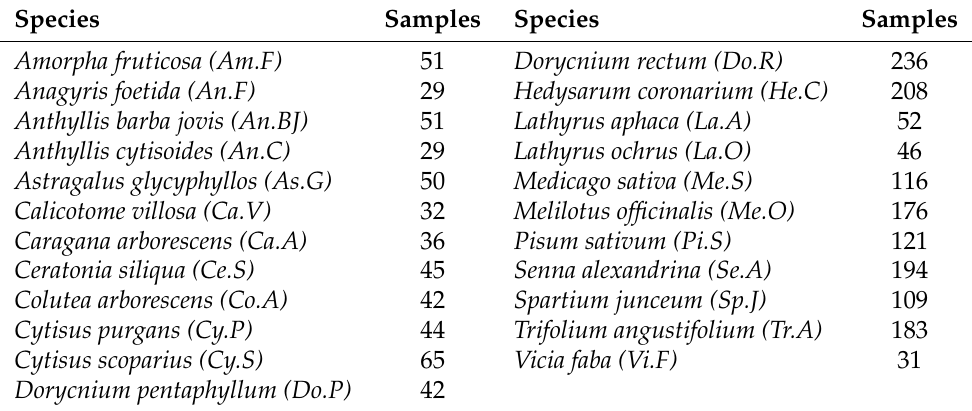
Table 4. Cagliari data set description: species name and number of samples.